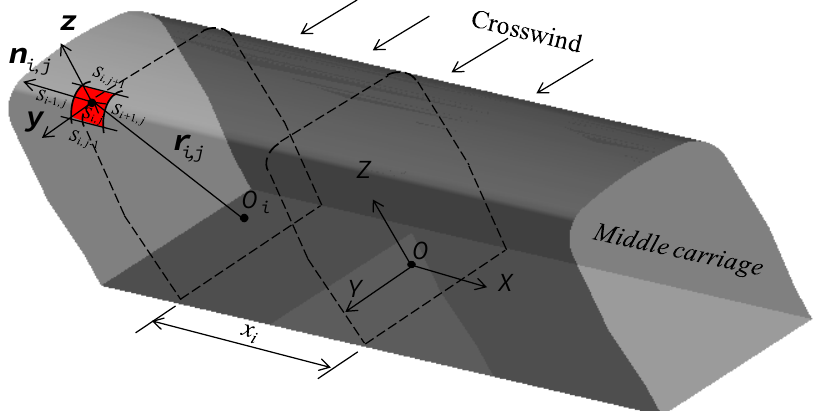
Figure 5. Calculation schematic of aerodynamic loads.